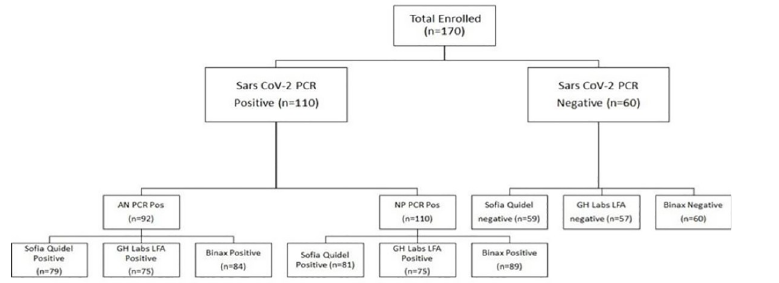
Fig 1. Flowchart of samples positive and negative for study tests.